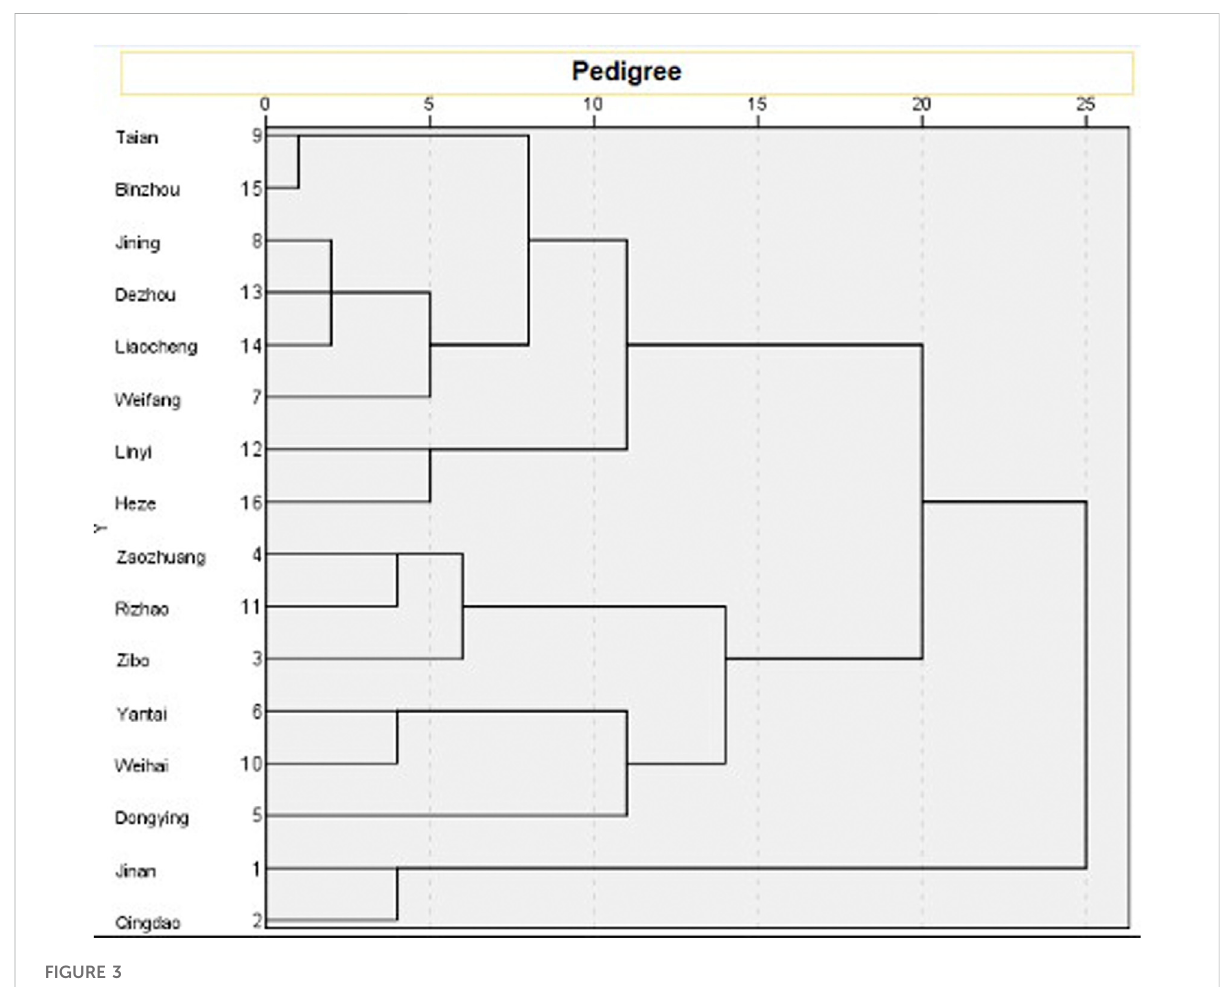
FIGURE 3 The dendrogram of cluster analysis.